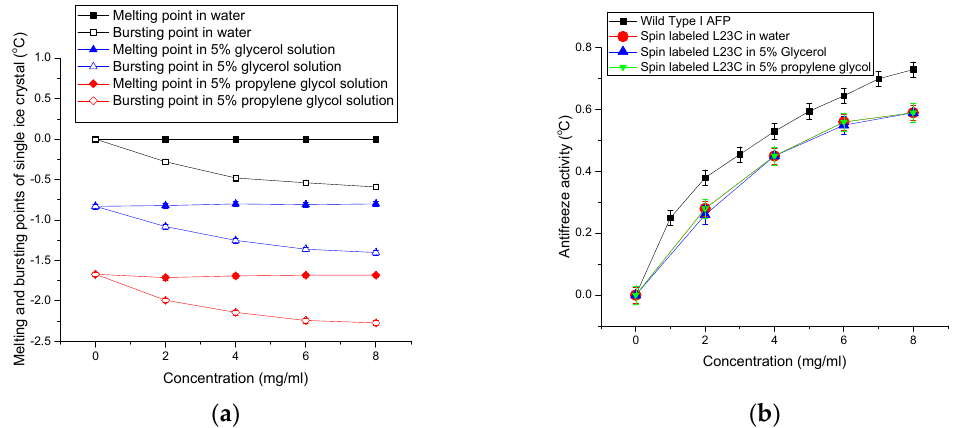
Figure 2. ( a ) Melting and bursting points of ice crystals in the spin labeled L23C water, 5% glycerol, and 5% propylene glycol solutions, respectively; and ( b ) antifreeze activities of the wild Type I AFP, and the spin-labeled L23C in water, 5% glycerol and 5% propylene glycol solutions, respectively.